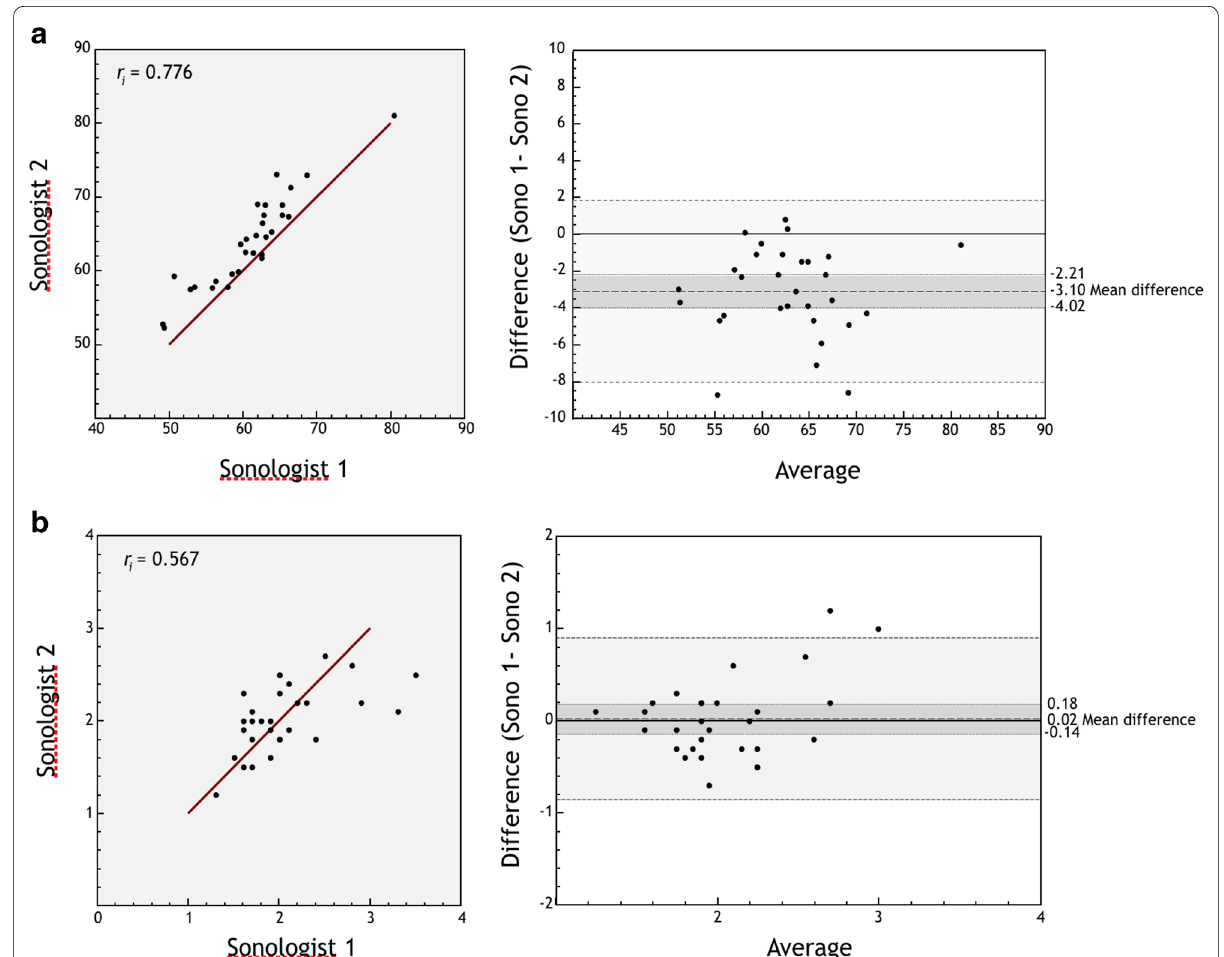
Fig. 3 ICC graphs and Bland–Altman plots: agreement between sonologists in measurements. Y axis for Bland–Altman plots represents average of sonologists measurements. Mean difference between sonologists with 95% confidence intervals on the means shown (darker gray). Lighter gray bands represent the 95% confidence bands. a Skin tongue thickness (mm). b Epiglottis SA